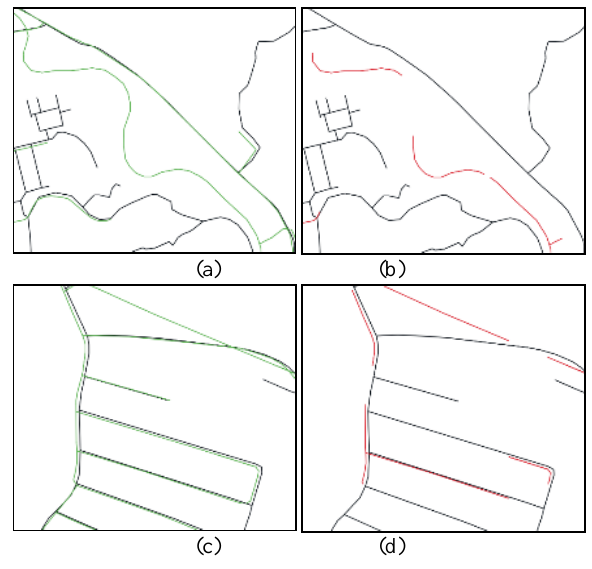
Figure 1 . Errors in fusion process